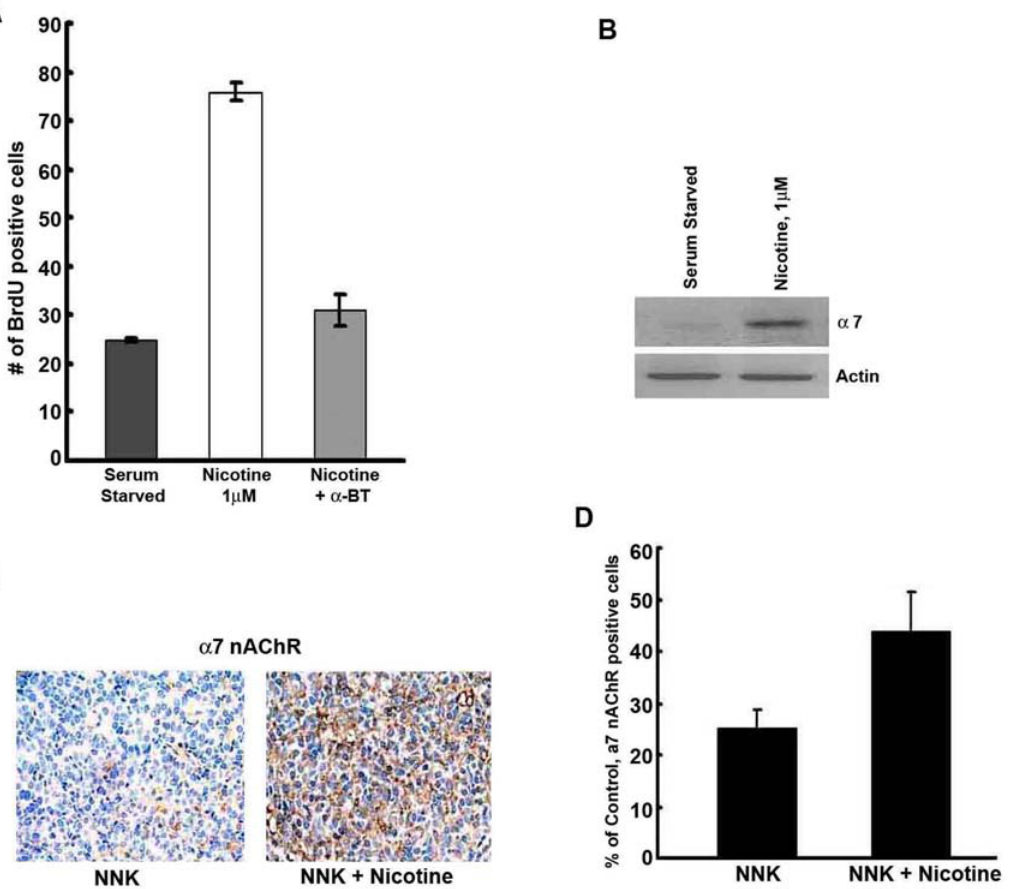
Figure 4. Nicotine enhances a 7 nAChR subunit expression in Line1 cells. (A) Quiescent Line1 cells were treated with 1 m M nicotine for 18 h in the presence or absence of a -BT, an a 7 nAChR subunit inhibitor. Nicotine enhances a 7 expression, while a -BT reverses this. (B) Reverse-transcriptase coupled-PCR showing the expression of a 7 nAChR subunits in serum starved Line1 cells treated with nicotine for 24 h. PCR for actin was used as the loading control. (C) a 7 nAChR staining of A/J lung tumors induced by NNK or induced by NNK and exposed to Nicotine. Nicotine enhances the expression of this receptor subunit. (D) Quantitation of a 7 nAChR expression in vehicle and nicotine treated tumors.